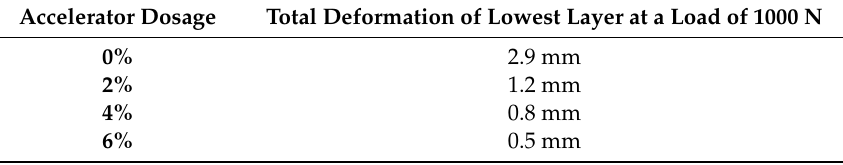
Table 3. Total deformation of lowest layer for a loading of 1000 N (equal to 50 additional layers or a wall with a height of approximately 1.5 m) 10 min after deposition.